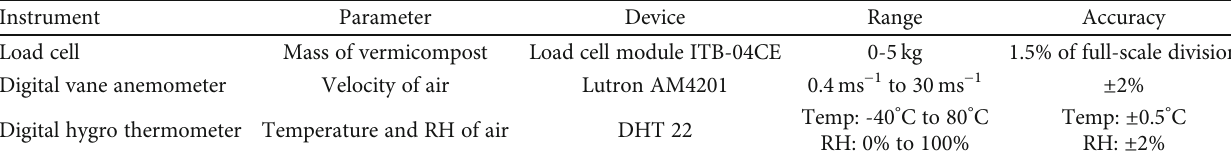
Table 2: Speci fi cations of the measuring instruments.